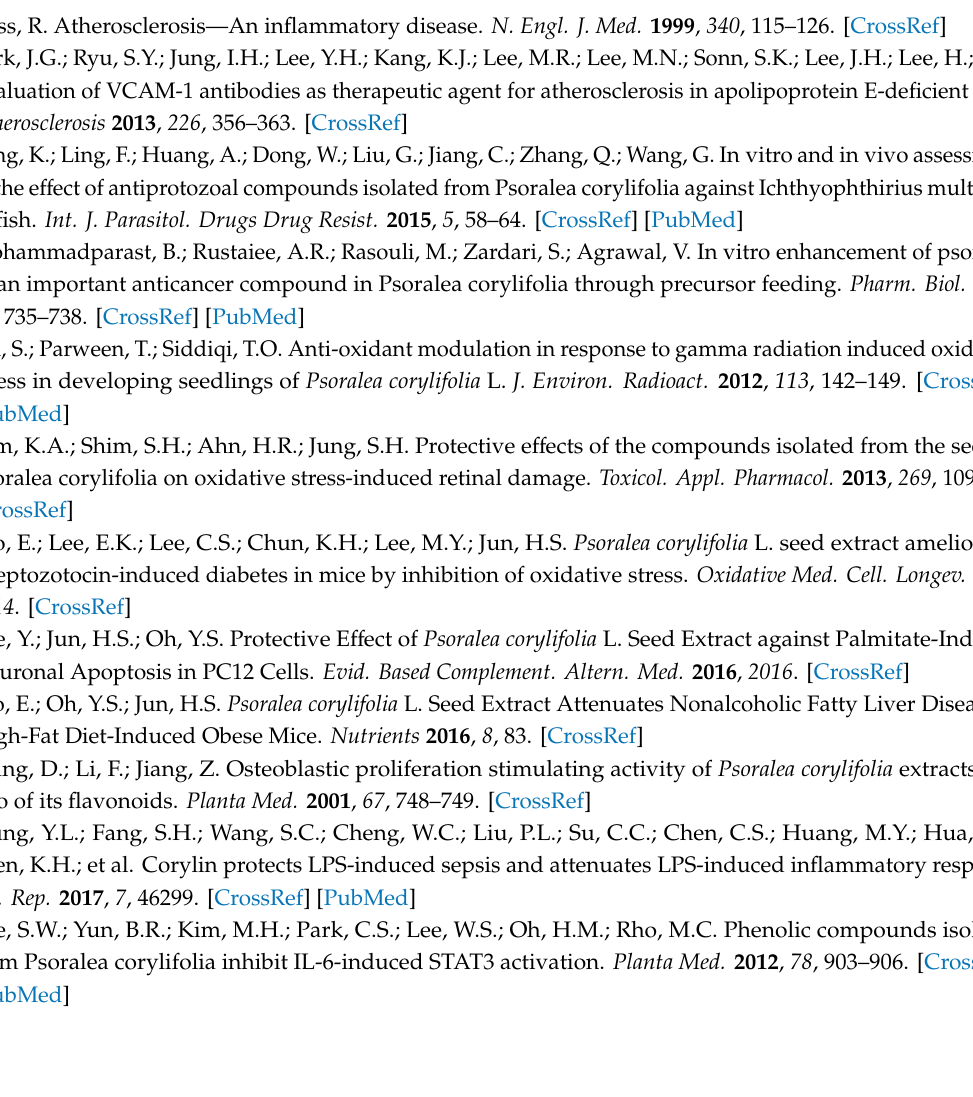
Figure S1: Corylin has no e ff ect on ICAM-1 and E-selectin expression in TNF- α -treated HUVECs and VSMCs. HUVECs (A) and serum-starved VSMCs (B) were pretreated (1 h) with corylin (10 or 20 µ M) and then treated with 10 ng / mL TNF- α for 24 h. ICAM-1 and E-selectin expression were analyzed by western blotting. β -actin was used as an internal control for sample loading. CTRL, control group, VSMCs were cultured without any treatment. The data are provided as the mean ± SD. * p < 0.05, Figure S2: Corylin reduces the activation of NF- κ B p65 in TNF- α -treated HUVECs and VSMCs. (A,B)HUVECs were pretreated (1 h) with 20 µ M corylin or 30 nM SP600125 (SP30) and then incubated with 10 ng / mL TNF- α (T) for 15 min. VSMCs were pretreated (1 h) with 20 µ M corylin, 30 µ M SB203580 (SB30), 30 µ M PD98059 (PD30), or 30 nM SP600125 (SP30) and then incubated with 10 ng / mL TNF- α (T) for 15 min. Western blot analysis for phosphorylated NF- κ B p65 (P-p65) and quantification of P-p65 to Total NF- κ B p65 (T-p65) in VSMCs. The data are provided as the mean ± SD. * p < 0.05 versus the untreated group (CTRL). † p < 0.05 versus the TNF- α -treated group, Figure S3: Corylin reduces the VCAM-1 expression in TNF- α -treated HUVECs and VSMCs via NF- κ B p65 pathway. (A,B) HUVECs and VSMCs were pretreated (1 h) with corylin (20 µ M; C20) or 10 µ M parthenolide (PAR) and then treated with 10 ng / mL TNF- α for 24 h. Western blot analysis for VCAM-1 and quantification of VCAM-1 to GAPDH in VSMCs. The data are provided as the mean ± SD. * p < 0.05 versus the untreated group (CTRL). † p < 0.05 versus the TNF- α -treated